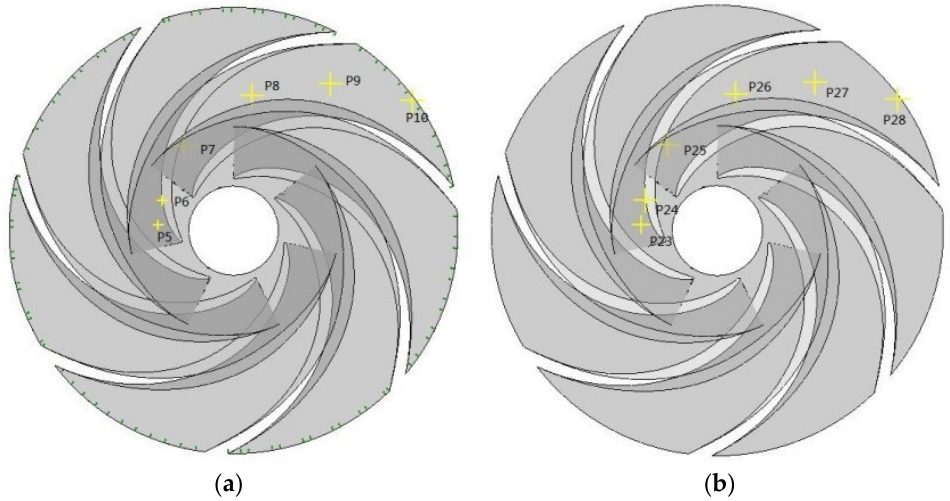
Figure 2. Distribution of the monitoring points in the impeller. ( a ) Primary impeller and ( b ) secondary impeller.